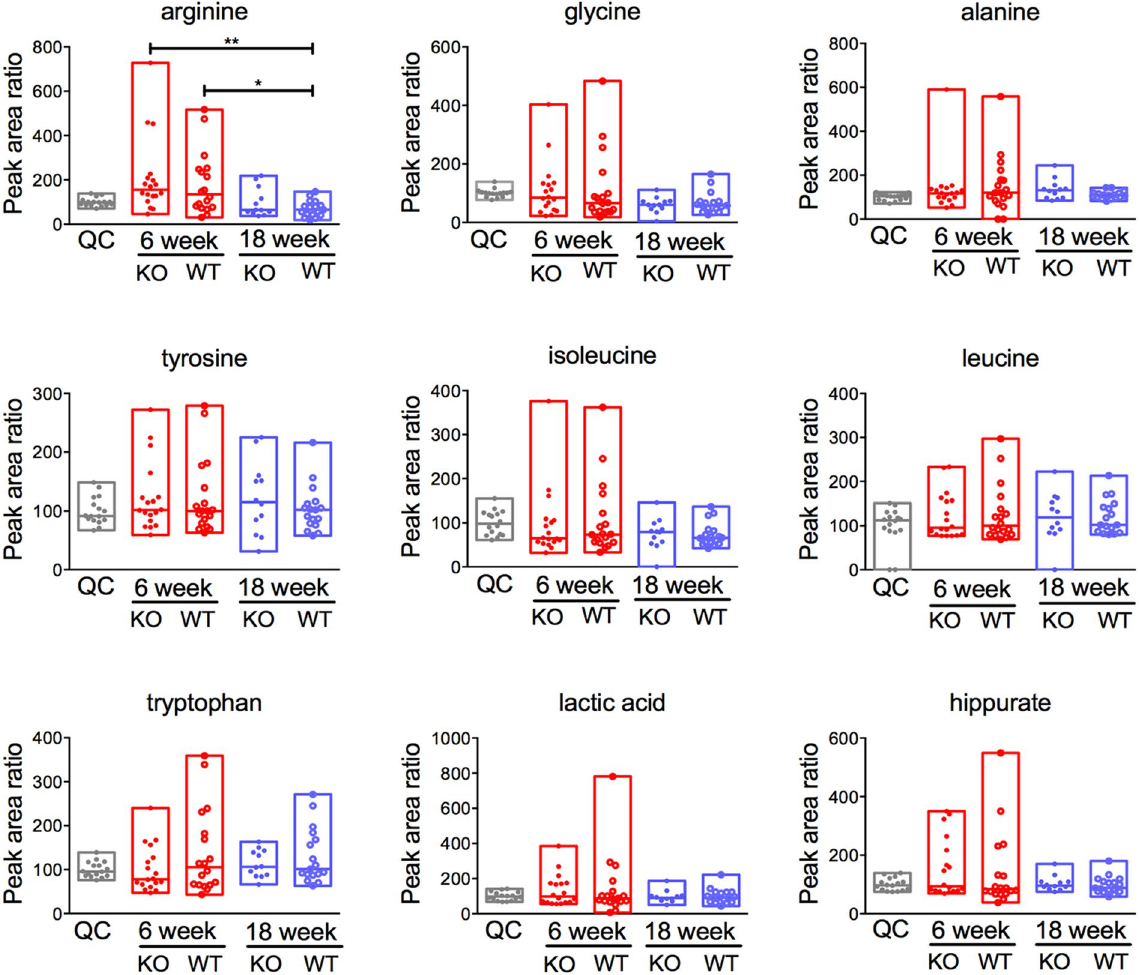
Figure 2. IBD marker metabolites in urine samples from WT and mdr1a − / − mice at 6 and 18 weeks. No differences were identified in the quantities of metabolites when comparing samples of the same genotype across time or between WT and KO samples at 6 weeks or 18 weeks. Creatine was used as an internal control. N = 18 WT 6 weeks, N = 18 mdr1a − / − 6 weeks, N = 17 WT 18 weeks and N = 12 mdr1a − / − 18 weeks. The median is shown as a line and bars capture the minimum and maximum. * P < 0.05; ** P < 0.01 as determined by Kruskal-Wallis test with Dunn’s multiple comparisons